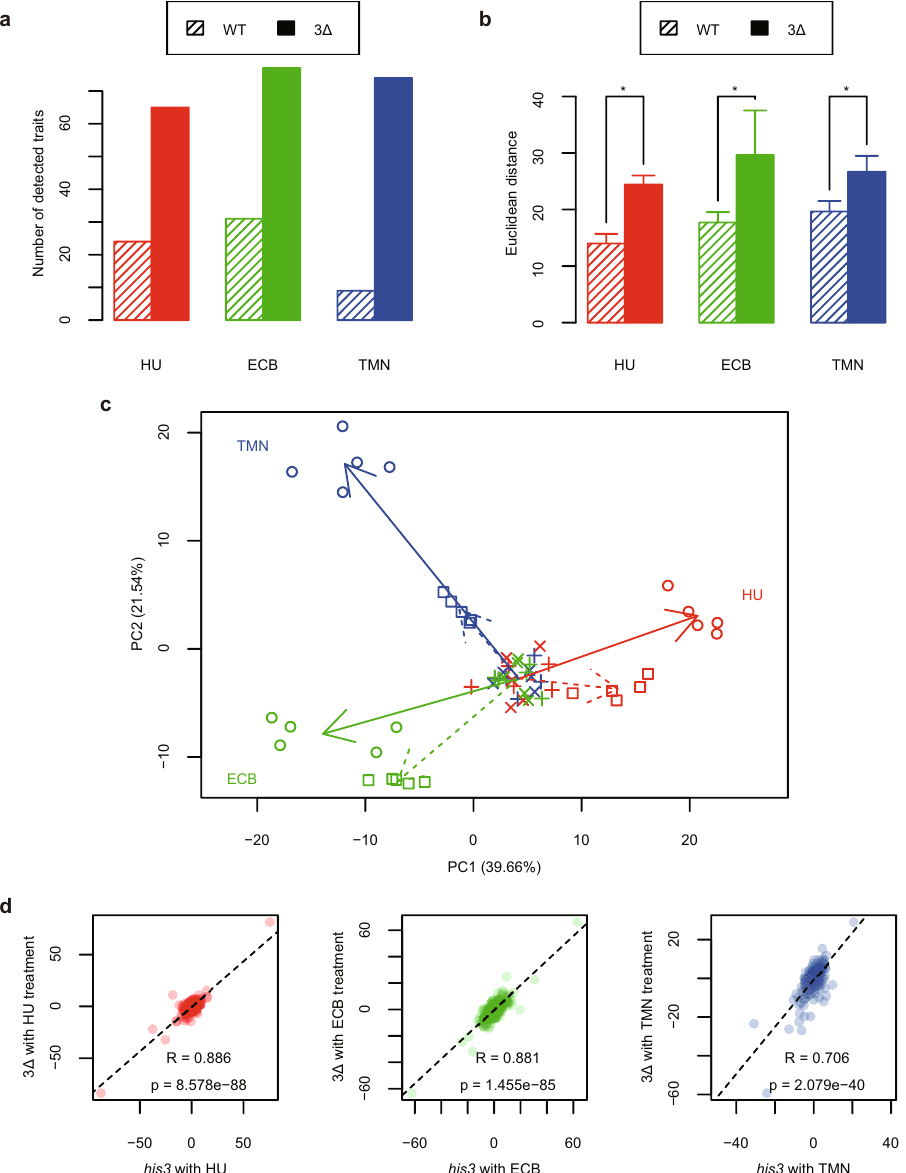
Fig. 3 Effectiveness of bioactive compounds in the drug-hypersensitive strain. a Number of morphological traits changed by drug treatment in the drug-hypersensitive strain (solid bar) and its wild-type strain ( his3 Δ , shaded bar). HU, ECB, and TMN indicate 8 and 10 mM of HU for the drug-hypersensitive strain and his3 Δ , respectively, 2.0 μ g/mL ECB for both strains, and 100 ng/mL TMN for both strains. b Drug- treatment-induced changes in holistic morphological abnormality in the drug-hypersensitive strain (solid bar) and his3 Δ (shaded bar). Error bars indicate standard deviations. Asterisks indicate a signi fi cant difference at p < 0.01 after Bonferroni correction by the likelihood-ratio test. c PCA plot showing morphological pro fi les of the drug-hypersensitive strain (circle) and his3 Δ (square) induced by HU, ECB, and TMN. The drug-hypersensitive strain (cross) and his3 Δ (plus) without drug treatment are also shown. Directions of morphological changes induced by HU, ECB, and TMN are shown as arrows in the drug-hypersensitive cells (solid) and his3 Δ (dashed). Percentages in parentheses indicate the proportion of variance explained by each PC. d Similarity of morphological pro fi les between the drug-hypersensitive strain and his3 Δ after treatment with HU, ECB, and TMN. PC scores of 259 PCs were plotted between his3 Δ ( x -axis) and 3 Δ ( y -axis) after chemical treatment. R and p indicate the Pearson product-moment correlation coef fi cient and the p -value calculated by the